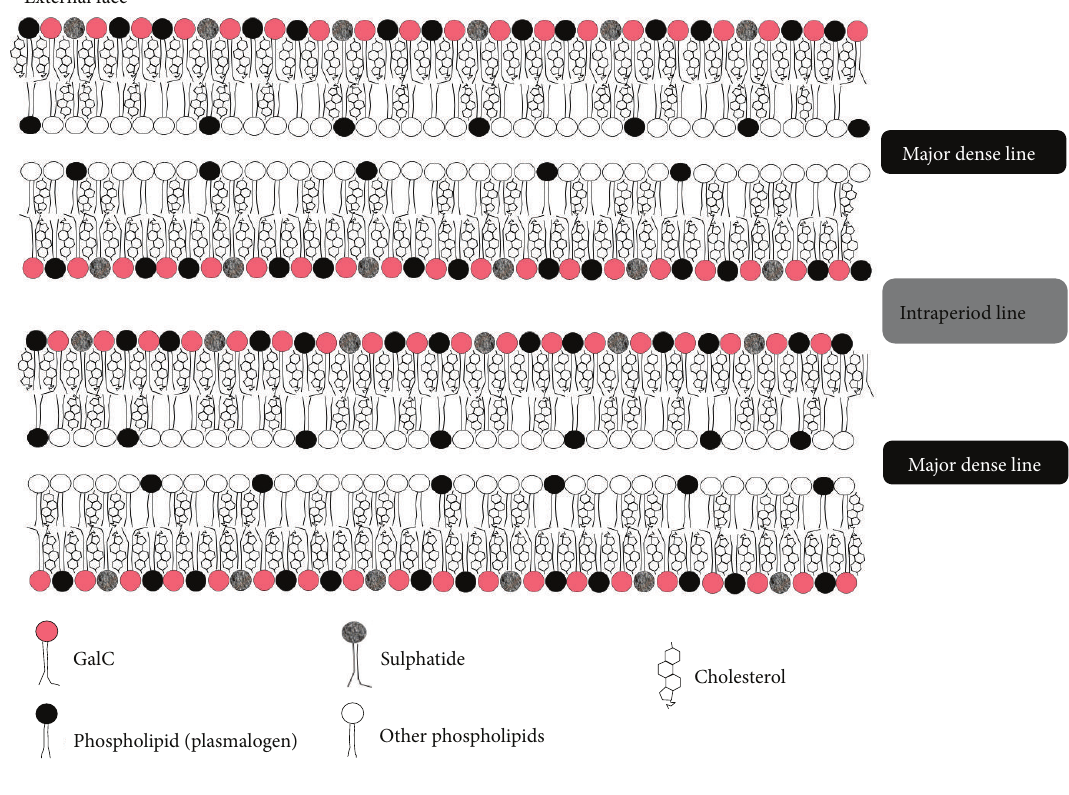
Figure 3: The distribution of lipids in CNS compact myelin. GalC and sulphatide are asymmetrically distributed, being highly enriched on the outer surfaces of the membranes. The molar ratio of each of the major classes of lipids is approximately as shown in the